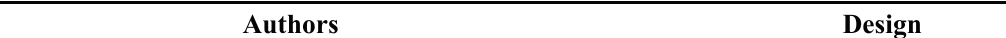
Table A1. List of included studies and their